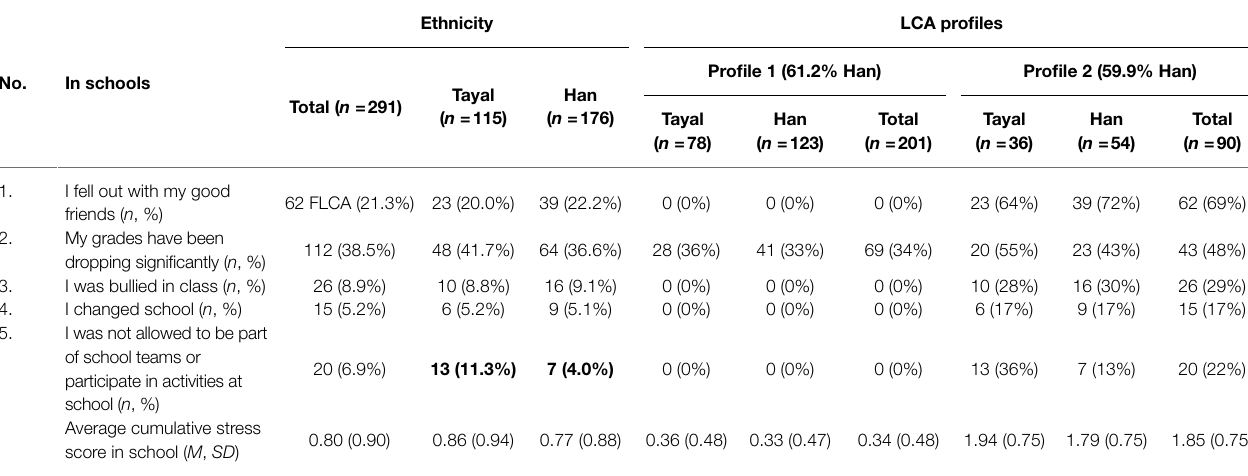
TABLE 4 | Descriptive information of stressful life events experienced in school by ethnicity and LCA